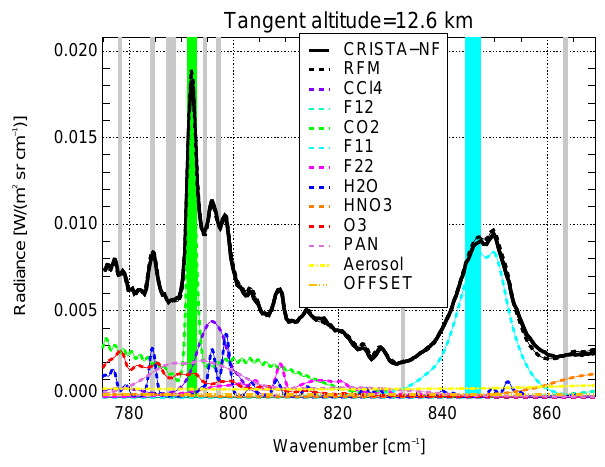
Fig. 1. Measured radiance spectra from detector LRS6 (776– 868cm − 1 ) from profile 87 during the local flight L5. Color coding shows the approximate tangent altitude (without retrieval correc- tions and refraction).